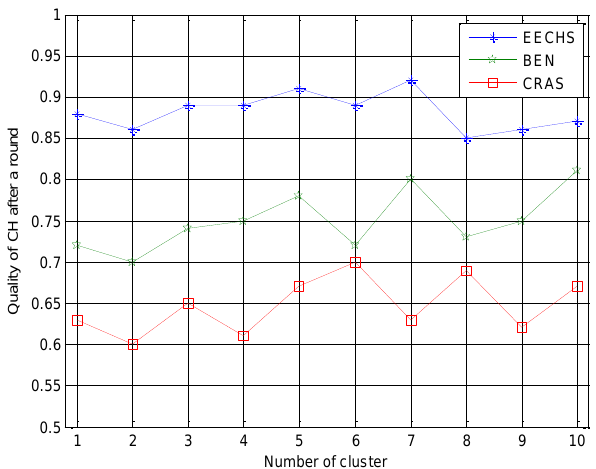
Figure 6. Experimental results for incremental energy of the CHs during the energy-harvesting